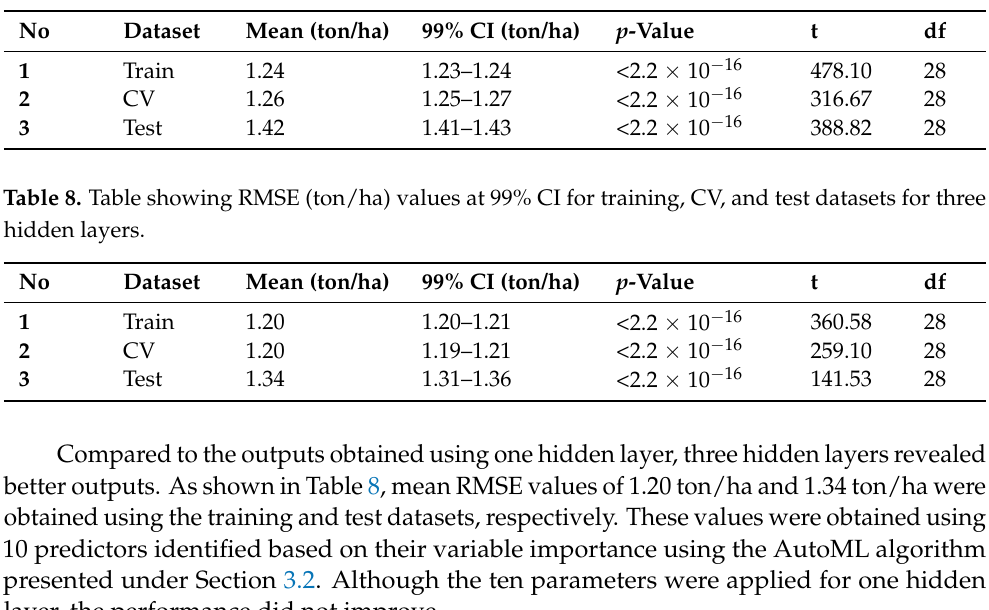
Table 7. Showing RMSE (ton/ha) values at a 99% CI for the training, CV, and test datasets for one hidden layer.